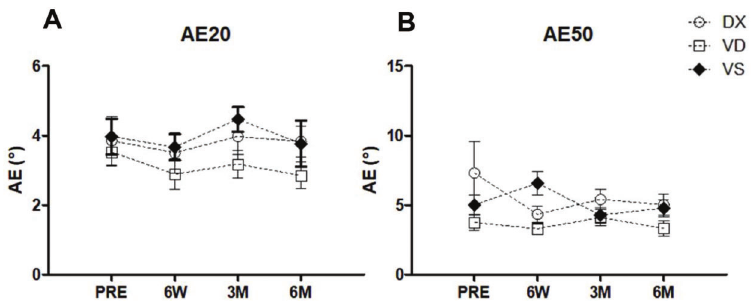
Figure 3 - Proprioception evaluation. A. Absolute error 20%. There were no significant differences regarding the AE20 over time ( p =0.30) or between groups ( p =0.20). B. Absolute error 50%. The same results were found for the AE50 over time ( p =0.35). General analysis showed a significant difference between groups ( p =0.036), which was not confirmed by pairwise comparison.